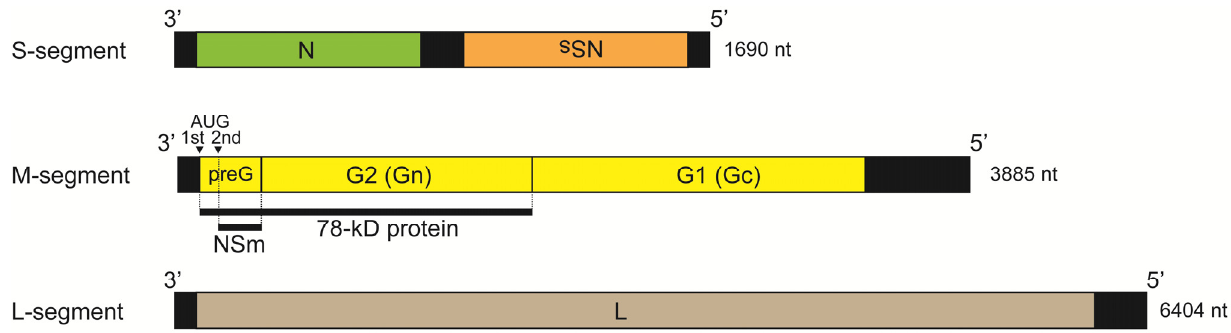
Figure 2. Schematic representation of Rift Valley fever virus (RVFV) genome